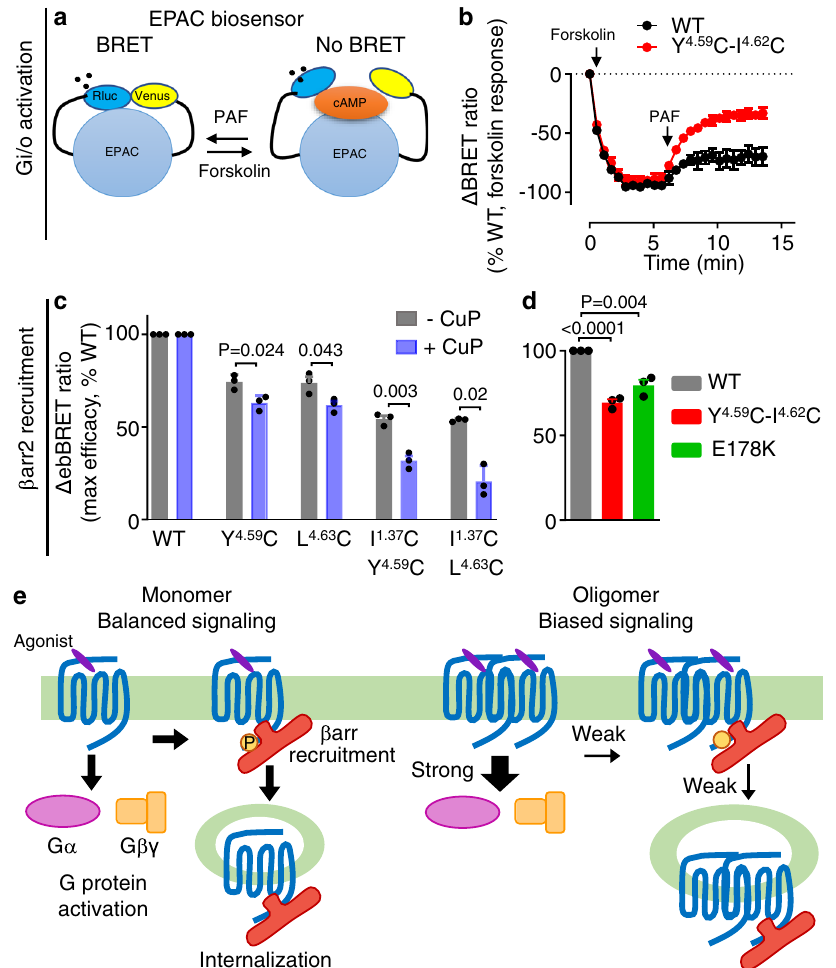
Fig. 7 | Biased signaling modulation by PAFR oligomerization. a Scheme illus- trating the BRET assay to measure the cAMP by the exchange protein directly activatedbycAMP(EPAC)sensorinHEK-293cells. b MonitoringofcAMPmediated by the WT Flag-tagged PAFR and the mutant. Forskolin (10 μ M) and PAF (5 μ M) were used to stimulate the cells. Data are mean±SEM from n =3 biologically independent experiments performed in triplicates and normalized to WT. c , d Recruitment of β arr2 to the cell membrane by the PAFR WT and indicated single or double mutants upon stimulation with PAF (1 μ M) and monitored by the